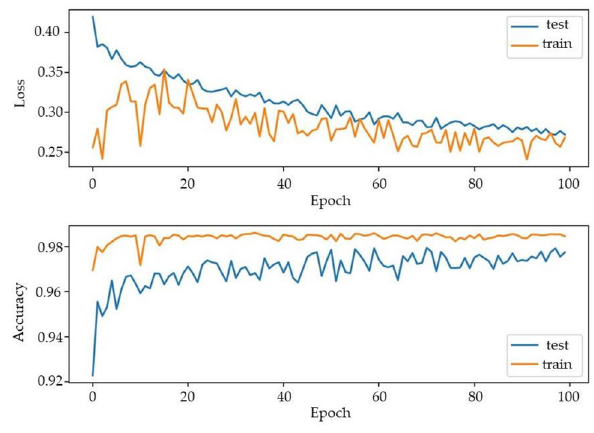
Fig. 7 The result of gesture segmentation